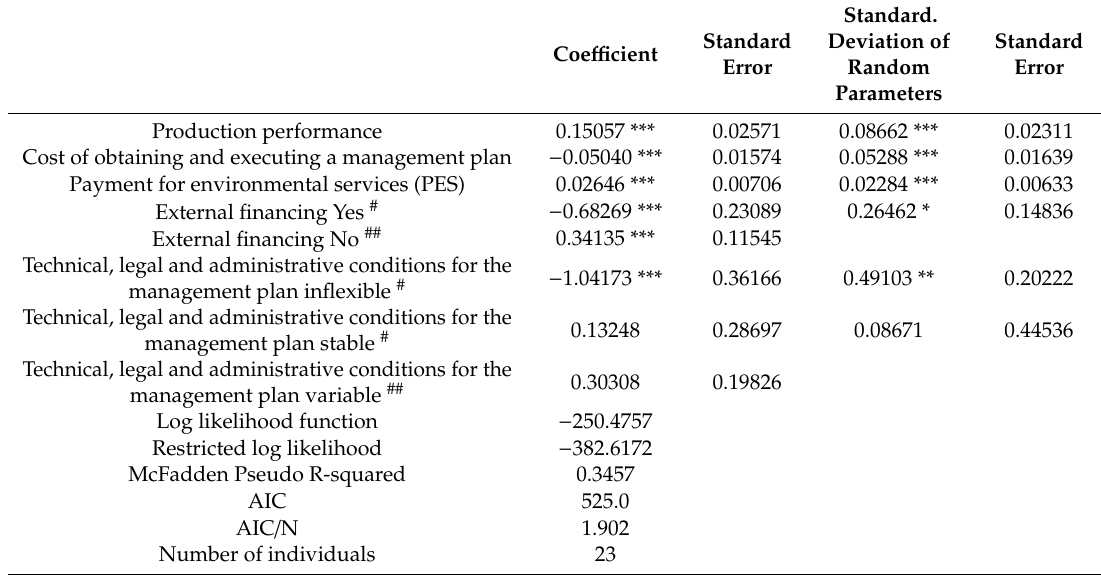
Table 4. Results of the estimation of the Random Parameters Logit model, for the most critical risk elements for the sustainability of a managed forest unit in the North Zone of Costa Rica—Round II.